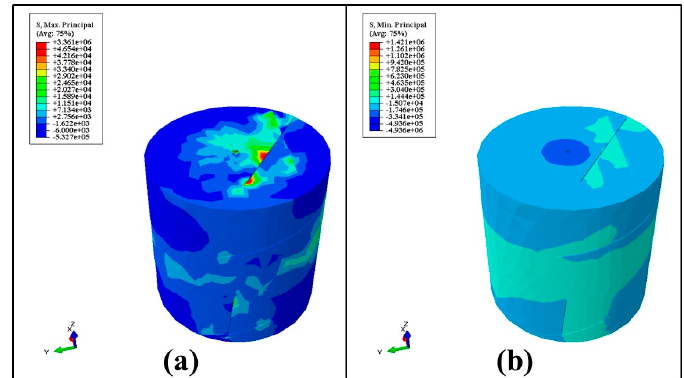
Figure 11. The principal stress contours. ( a ) The first principal stress contours, ( b ) the third principal stress contours.